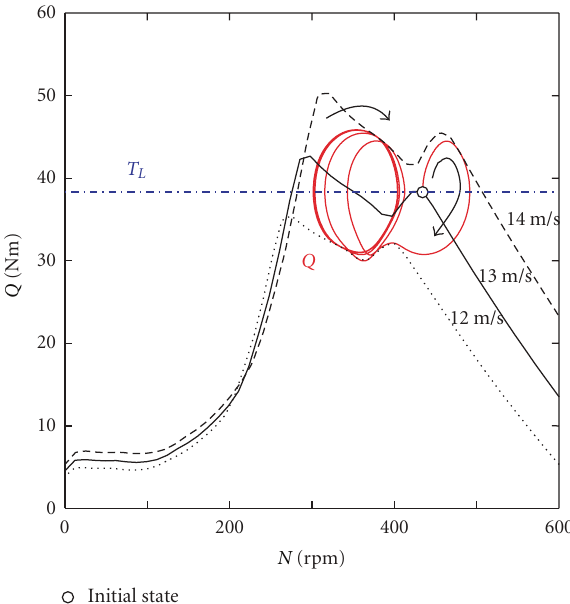
Figure 21: Locus of torque, Q , of pulsating wind in the case where V = 13m/s, T = 32 s, and I = 3 kgm 2 . Constant load torque is T L = 0 38.3 Nm. Final average rotational speed is N ave = 377.1 rpm.